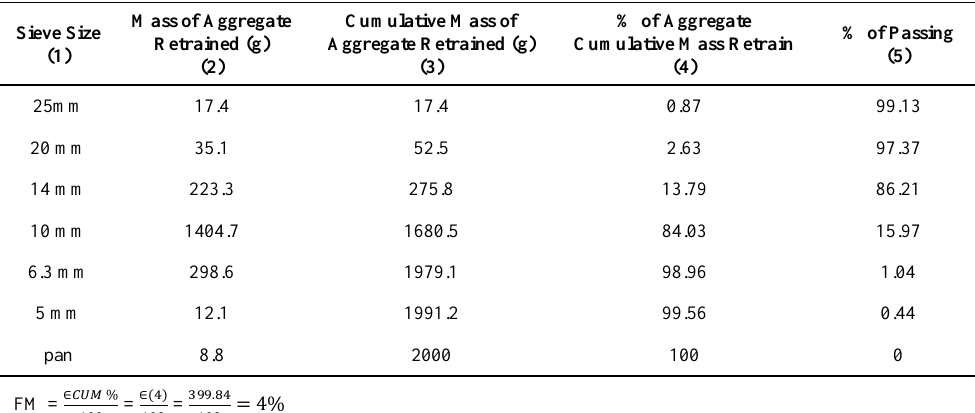
Table 3. Sieve analysis for recycled coarse